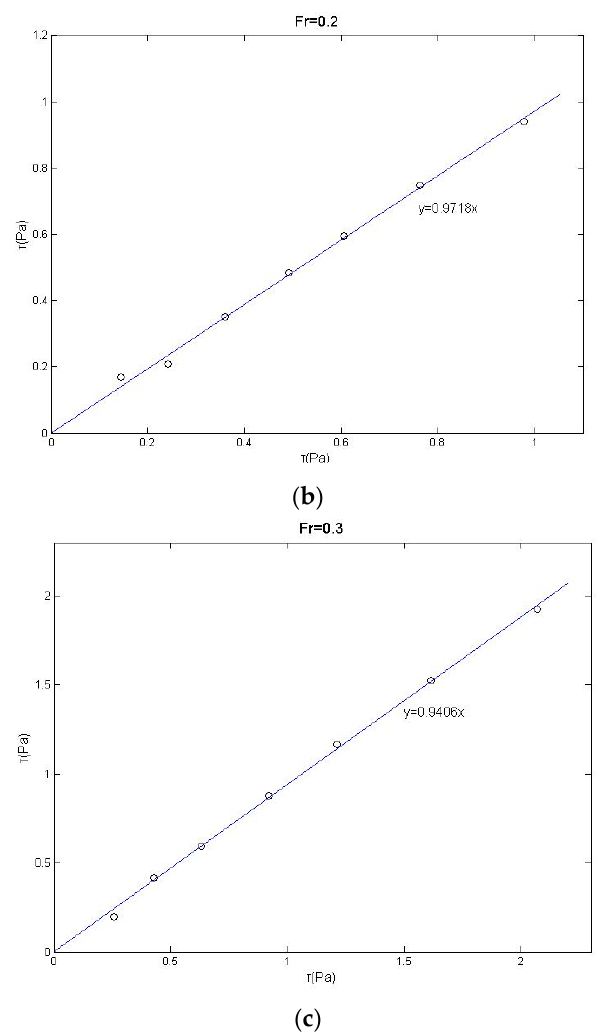
Figure 11. The correlation of the free surface modeled data and the rigid lid model (the circle is the modeled data, the line is the fitted line); ( a ) Fr = 0.1; ( b ) Fr = 0.2; ( c ) Fr = 0.3.